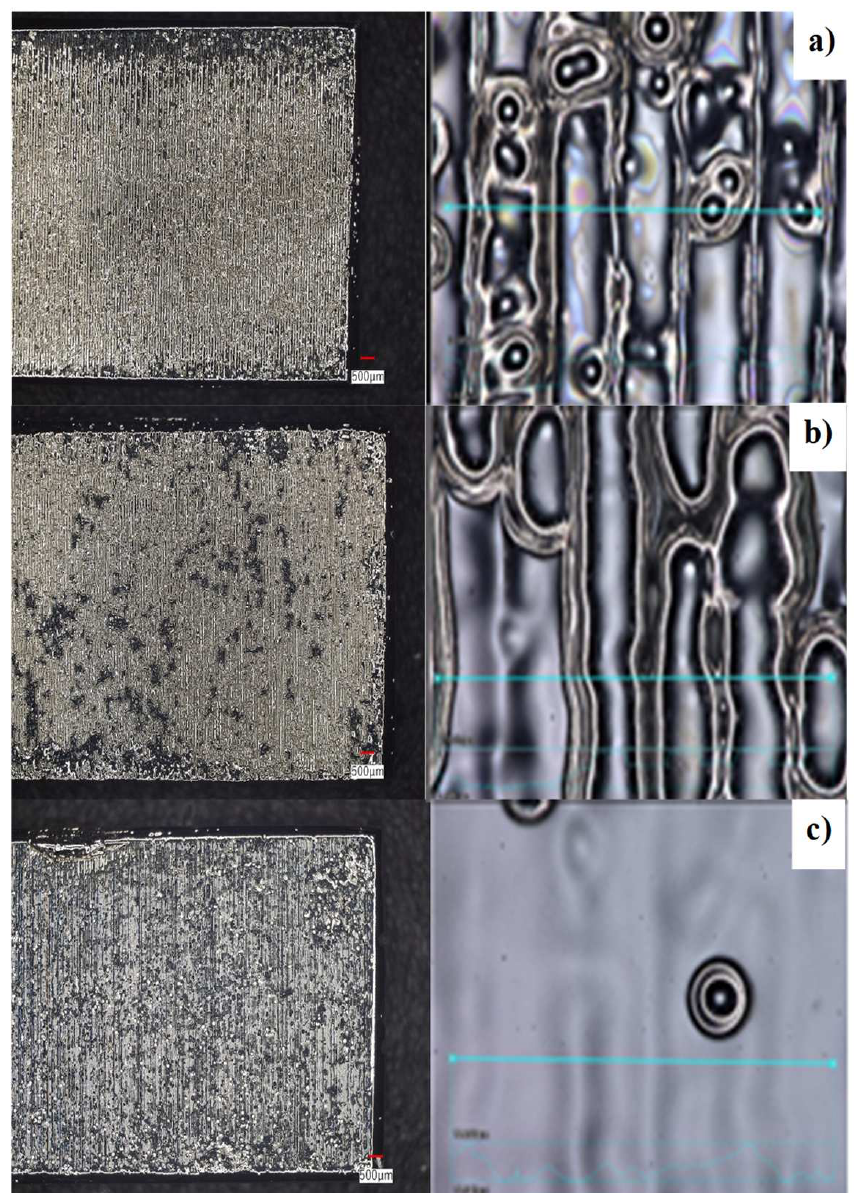
Figure 11. Overview of three rib-structured VGS–copper packages. ( a ) VGS-Cu package-1 with R max = 15 µ m, ( b ) VGS-Cu package-2 with R max = 45 µ m, and ( c ) VGS-Cu package-3 with R max = 7 µ m. The measured R max was 45 µ m for the specimen in Figure 11b with d = 45 µ m, and R max was 7 µ m in Figure 11c with d = 7 µ m. This revealed that the completely unfilled microgrooves by copper were left in the VGS-2 and VGS-3 specimens. This unfilling state came from the fall-down of microwalls between adjacent microgrooves during the plasma oxidation. That is, d > R max in Figure 11a proves that the micro-groove arrayed VGS is filled by a copper layer without any unfilled state. The copper deposition and filling process into microgrooves were investigated for the package in Figure 11a. Figure 12 depicts the surface profile of the VGS-Cu package in Figure 11a. Although some microgrooves without a fully filling state were detected by this microscopic laser measurement, most the microgrooves were fully filled to form a relatively smooth surface. The deep microgroove array in this VGS-1 with stiff micro-walls was near-fully filled by the copper deposits during the wet-plating to be free from surface